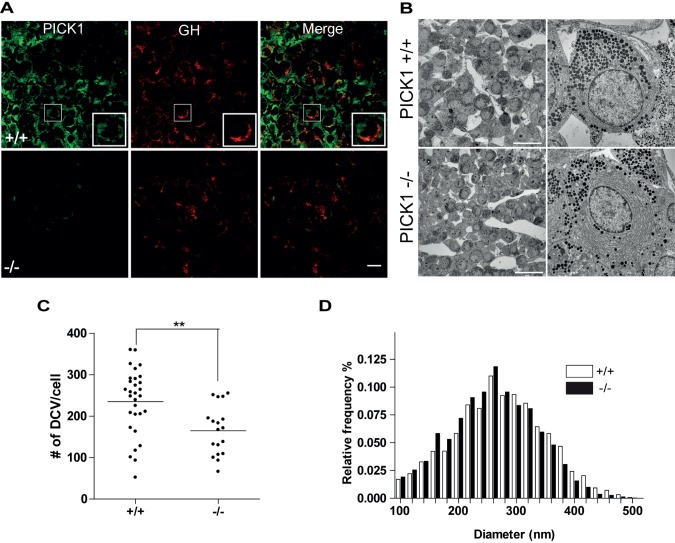
PICK1 deficiency leads to loss and altered localization of DCVs in the pituitary.(A) PICK1 is expressed in GH-producing cells of the pituitary. Confocal images of 15 µm slices from the pituitary of WT (+/+) (top) and PICK1-deficient mice (−/−) (bottom), immunostained for PICK1 (green) and GH (red). Insets show cells with characteristic intense arc-shaped distribution of GH and partial overlap with PICK1. Scale bar, 10 µm. Pictures are representative of stainings of seven pituitaries from WT and PICK1-deficient mice. (B) The number of DCVs is reduced in pituitary cells from PICK1-deficient mice. Transmission electron micrographs of uranyl acetate and lead citrate-stained ultrathin slices from the pituitary of WT (+/+) (top) and PICK1-deficient mice (−/−) (bottom). Scale bars, left, 20 µm. Pictures are representative of several pictures from five WT (+/+) and four PICK1-deficient (−/−) mice. (C) Quantification of the number of DCVs in 26 cells from WT (+/+) and 29 cells from PICK1-deficient (−/−) mice. **Average significantly different from control, p = 0.0022 in Student's t test. (D) Size distribution of DCVs in GH cells of the pituitary is unaltered in PICK1-deficient mice. The data show the relative frequency of different sizes of DCV in cells from PICK1-deficient mice (black) (n = 3,798) and in cells from WT mice (white) (n = 7,021).